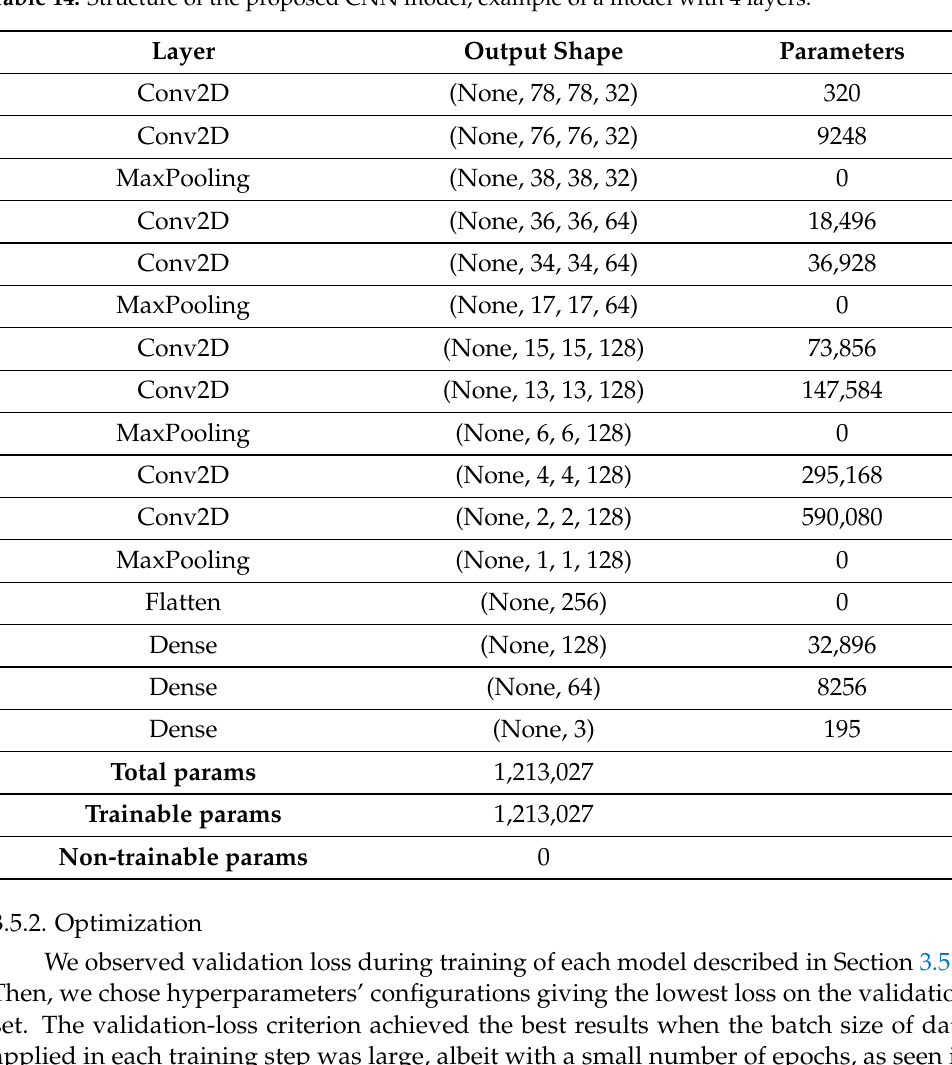
Table 14. Structure of the proposed CNN model; example of a model with 4 layers.